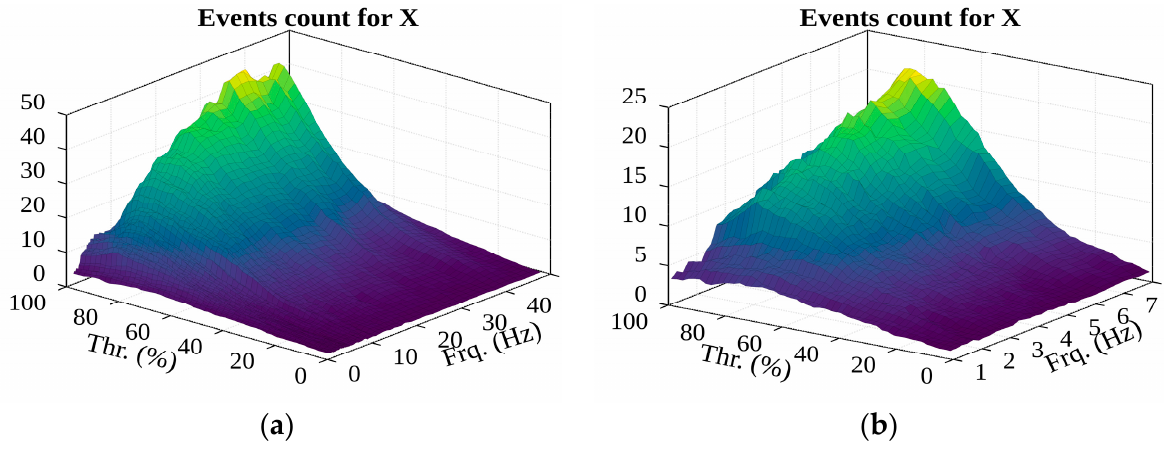
Figure 24. The surface of events (in the ( a )—1–49 Hz; ( b )—1–8 Hz frequency range). After calculating the RMS values of the filtered acceleration half-wave associated with each potential event, and then averaging them, a graph is obtained (see Figure 25). The expression used for this purpose is as